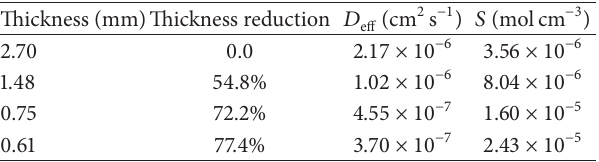
Table 2: Cold-rolled thickness reduction degree and corresponding diffusivity and solubility of